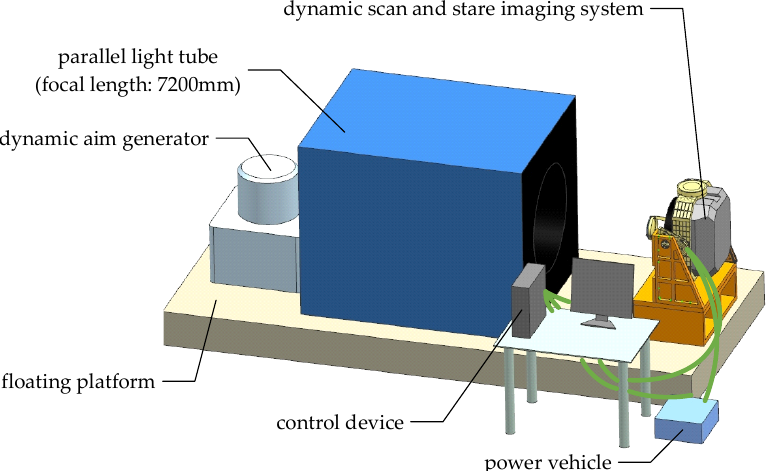
Figure 17. Schematic diagram of dynamic imaging test in laboratory.